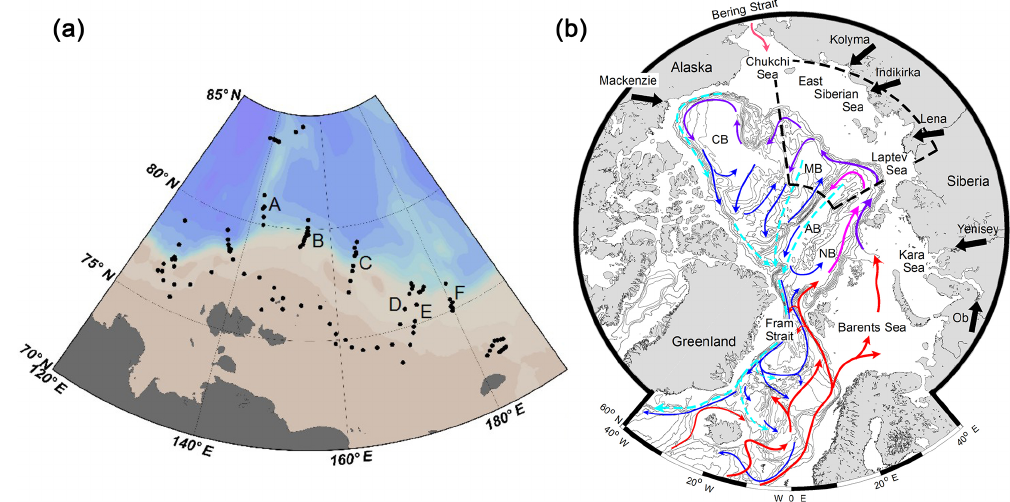
Figure 1. Map illustrating the station locations, with (a) sections noted and (b) general water mass circulation in the deep Arctic Ocean and its connection to surrounding oceans. The location of map in (a) is shown by the dotted insert in map (b)